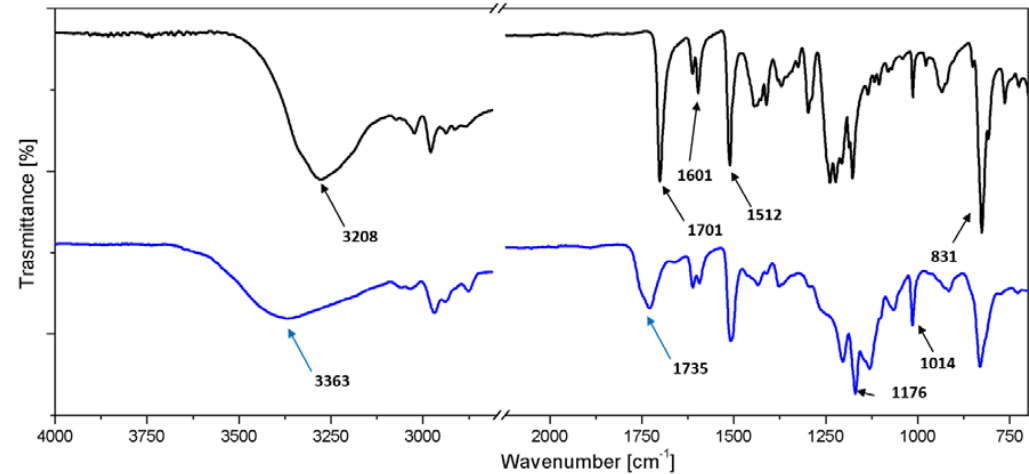
Figure 7. Fourier transform infrared (FTIR) spectra of diphenolic acid (black curve) and AHBP (blue curve).